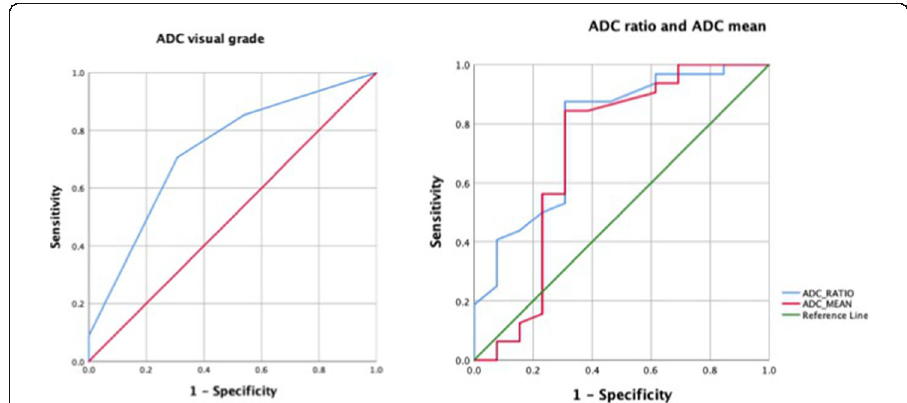
Fig. 3 ROC curves for ADC visual grade on the left and ADC ratio as well as mean ADC on the right. The lowest area under curve among the diffusion parameters was that for mean